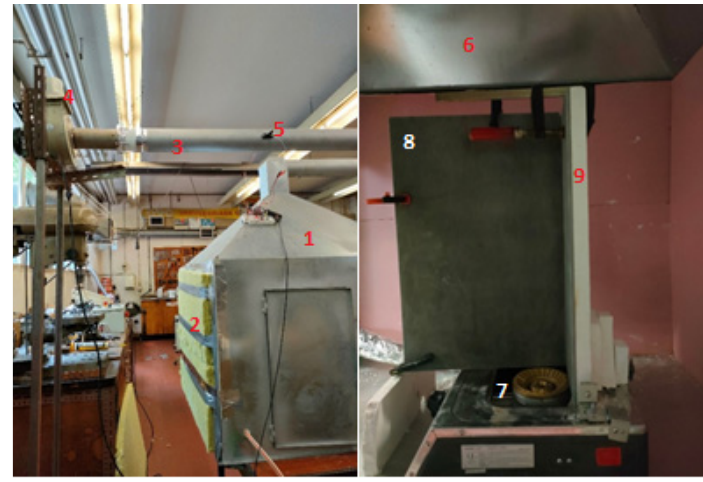
Figure 2. Main components of the smoke production test facility.